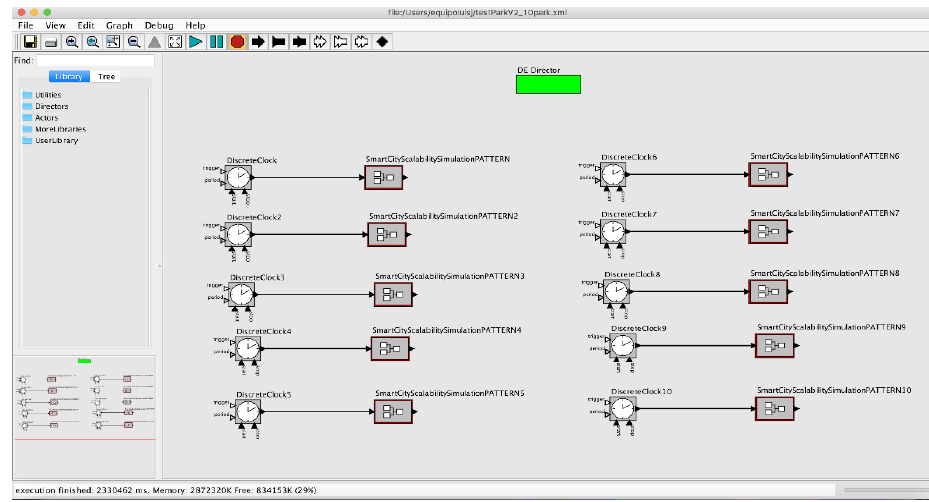
Figure 16. Model of the IoT application with 10 parks in a city.